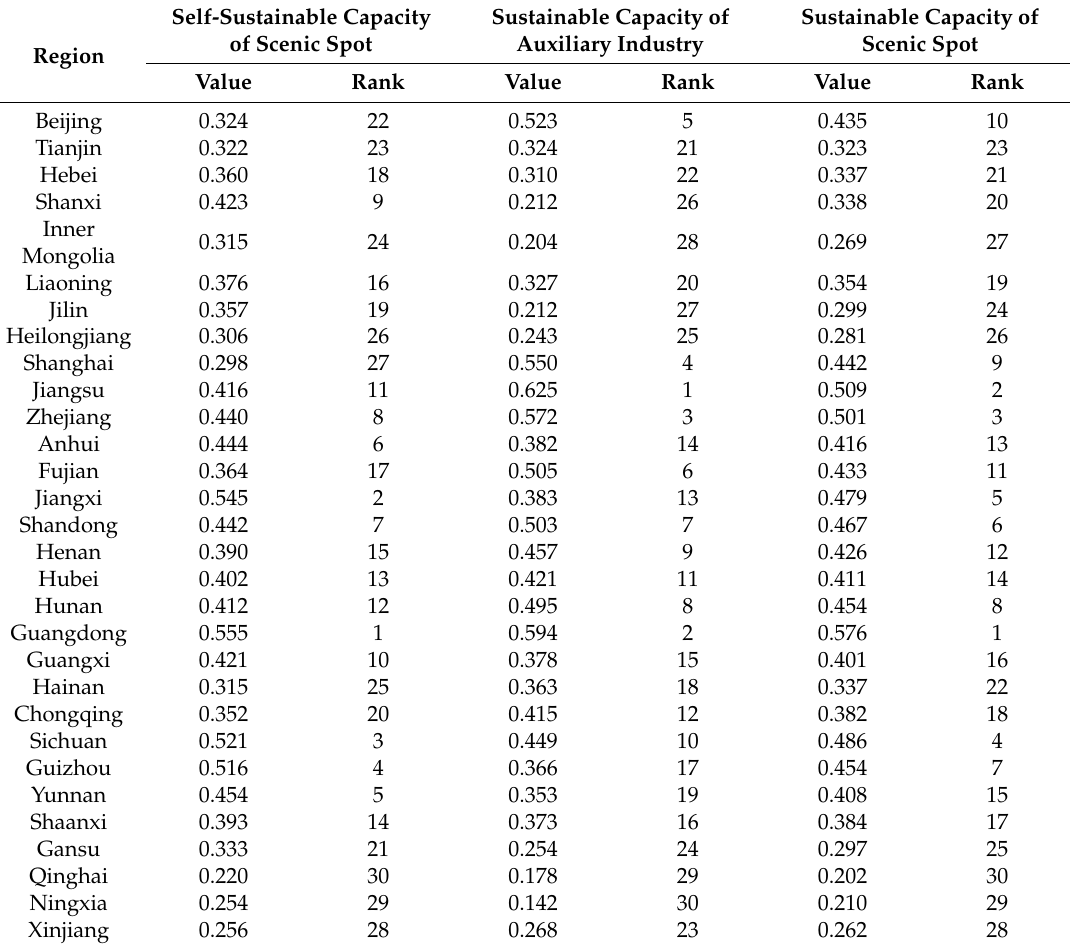
Table 7. Sustainable capacity value of scenic spots of 30 Chinese provinces and cities.